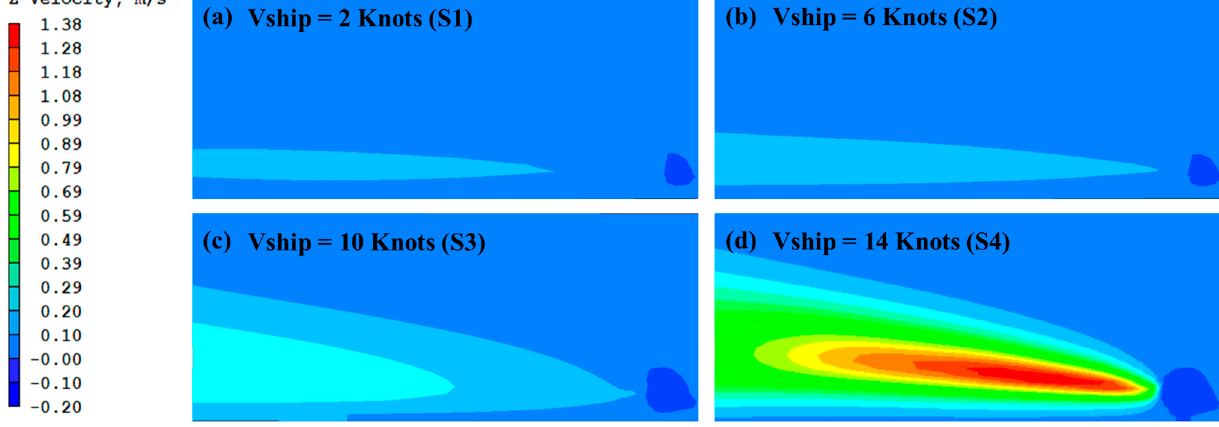
Figure 10. The vertical velocity contours influenced only by exhaust outlet movement in the V2 − T2 scenario at wind speeds of 3 m/s: ( a – d ) are S1, S2, S3, and S4 scenarios, respectively.